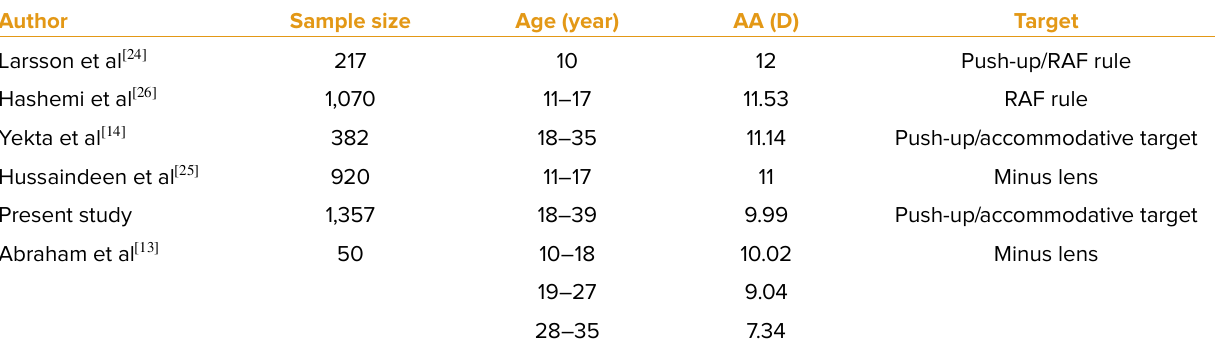
Table 3. Amplitude of accommodation reported by different studies